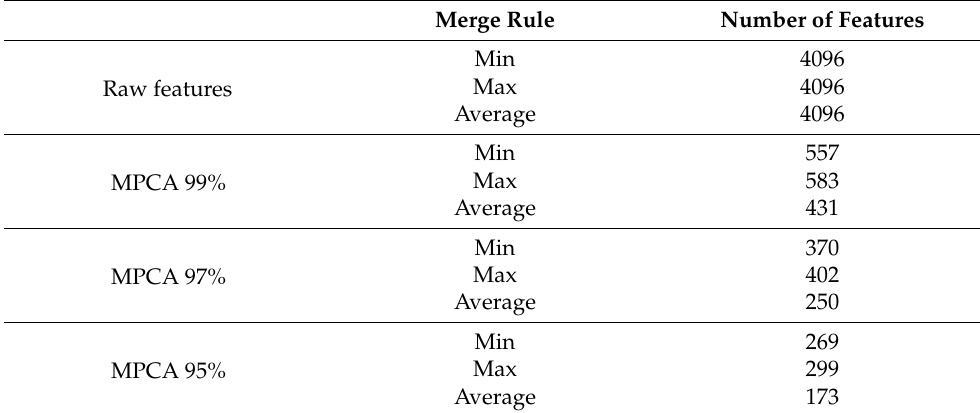
Table 2. Number of features before and after applying PCA on the merged F6 ⊕